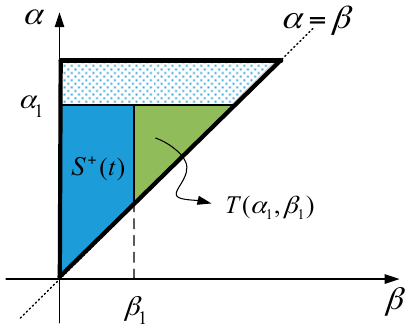
( b ) Figure 5. ( a ) Hysteresis operator; ( b ) The Preisach plane. The Preisach model in Equation (1) integrates multiple hysteresis operators. All the hysteresis operators can be demonstrated on the Preisach plane as shown in Figure 5b. (cid:1873) (cid:3040)(cid:3028)(cid:3051) indicates the maximum input value for the MSM actuator, and (cid:1873) (cid:3040)(cid:3036)(cid:3041) is zero voltage. The x -axis represents all the values of (cid:2010) and the y -axis represents the values of (cid:2009) . As the definition in Equation (1), (cid:2009) is always equal or larger than (cid:2010) . Therefore, the working area is limited within the upper right triangle as shown in Figure 5b. In this model, hysteresis is not only influenced by local extrema, which means it is not only related to the current input signal, but it is also influenced by the past position. Hence, it is important to know that saving past extrema is necessary in using the Preisach model. Next, to implement the Preisach model, a new function F ( α 1 ,  1 ) is defined as: